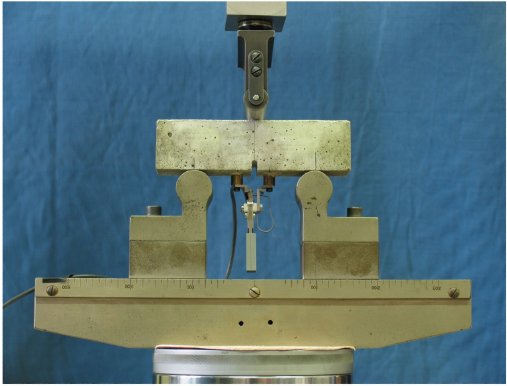
Figure 4. Three-point-bending tests in crack mouth opening displacement (CMOD) control